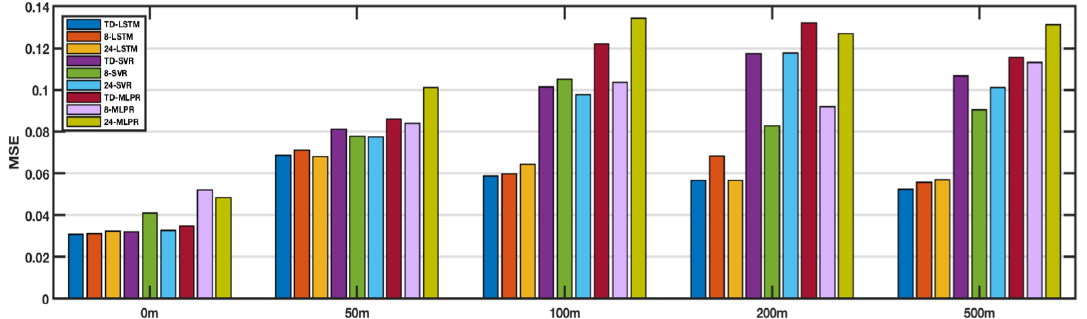
Figure 8. Comparison of performances at different depth in the Coral Seas.